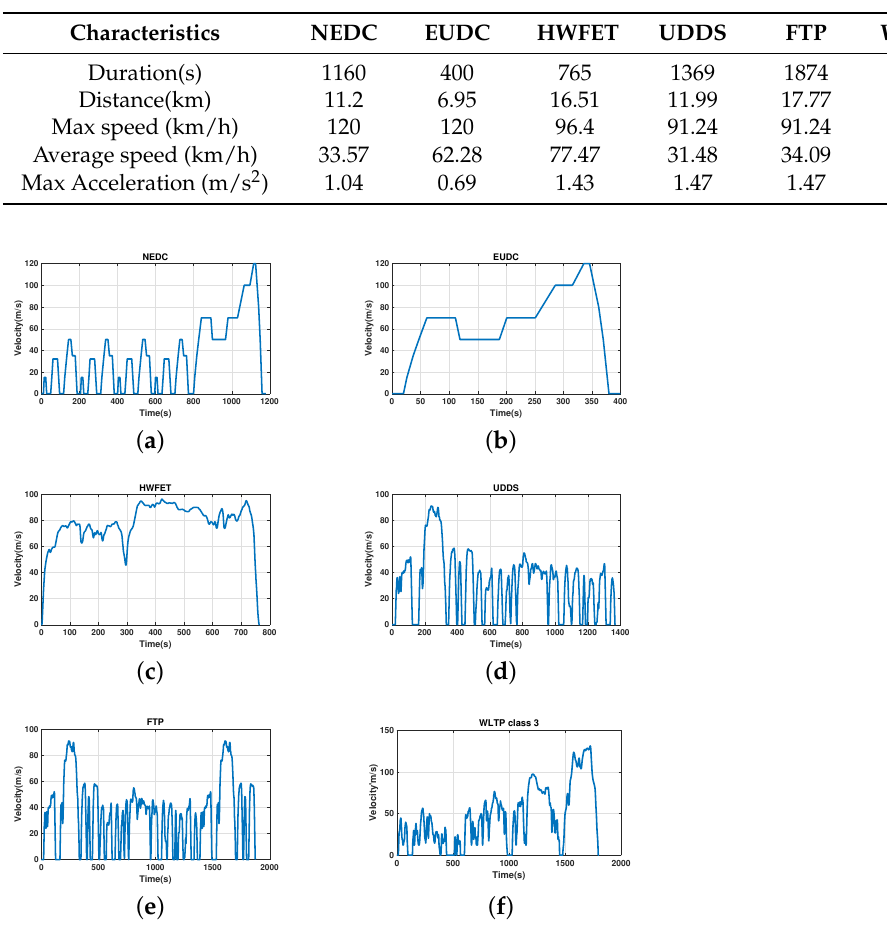
Table 2. Standard driving cycles characteristics.